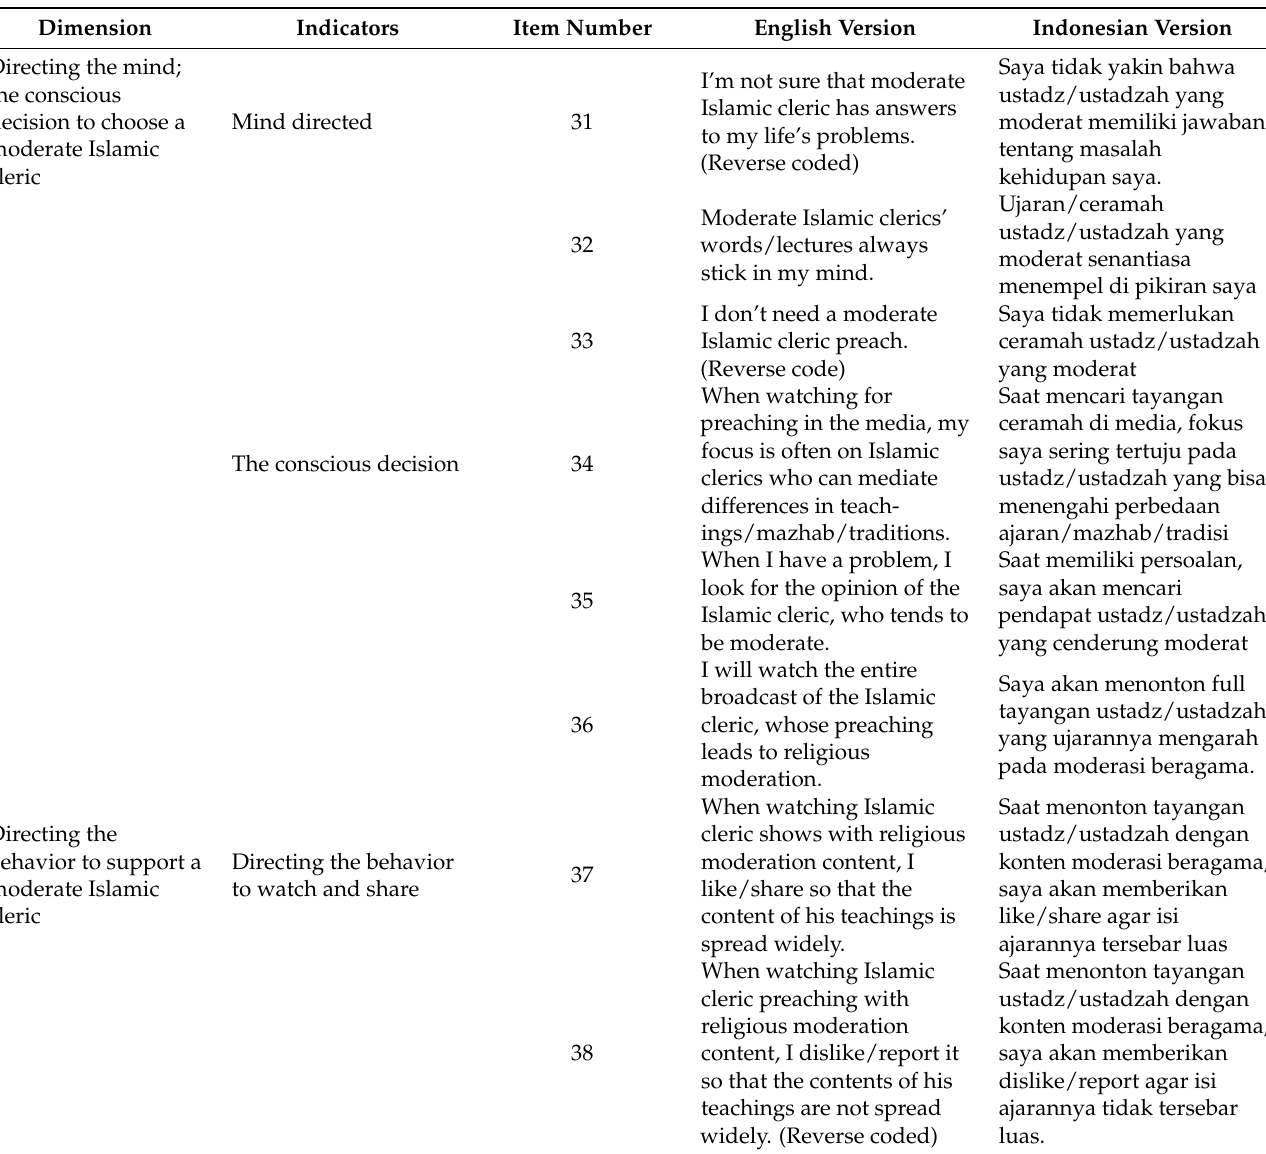
Table A3. Religious moderation